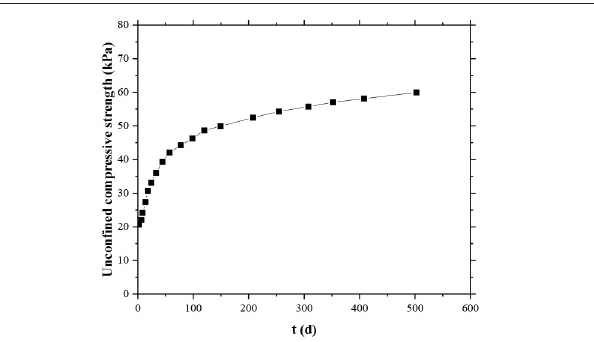
FIGURE 3 | Curve of relationship between unconfined compressive strength and curing time of remolded soil samples [modified from Zhang et al. (2014b)].